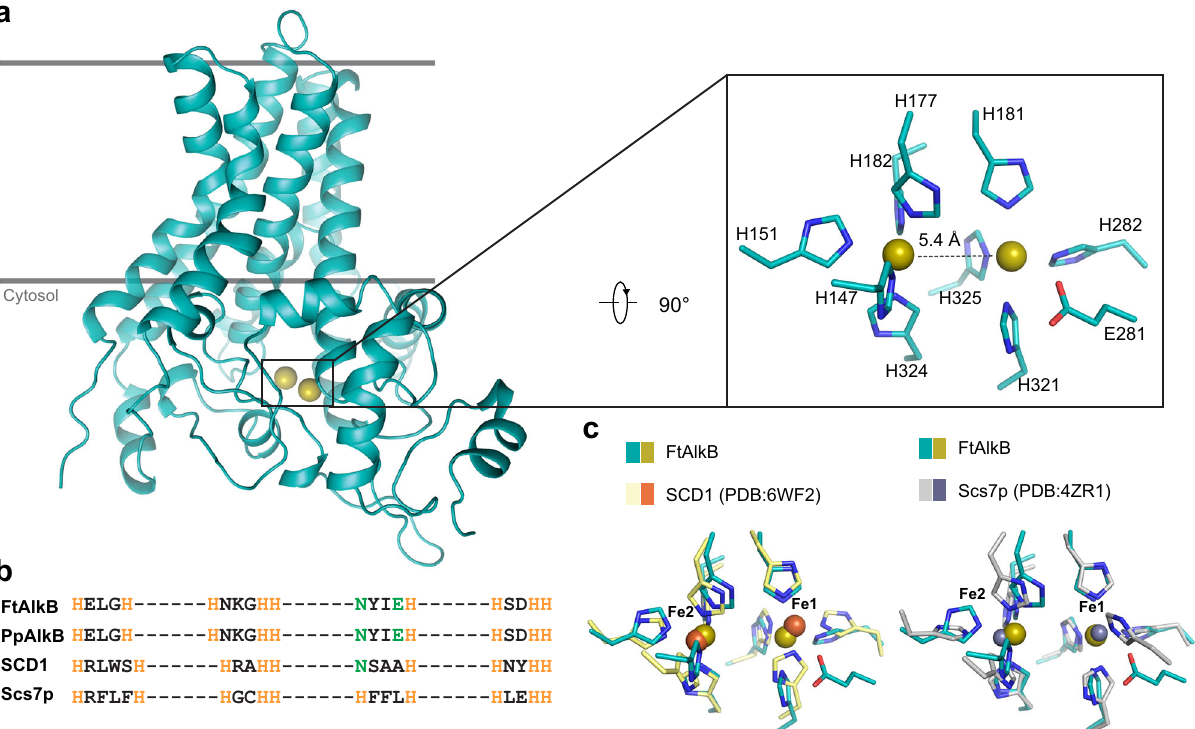
Fig.2|ThediironcenterofFtAlkB.a StructureofFtAlkBwithaclose-upviewofthediironcoordination.Thecoordinatinghistidineresiduesandasurroundingglutamate are shown in sticks. b Alignments of conserved histidine motifs. c Superimposition of diiron centers in the members of the FADS-like